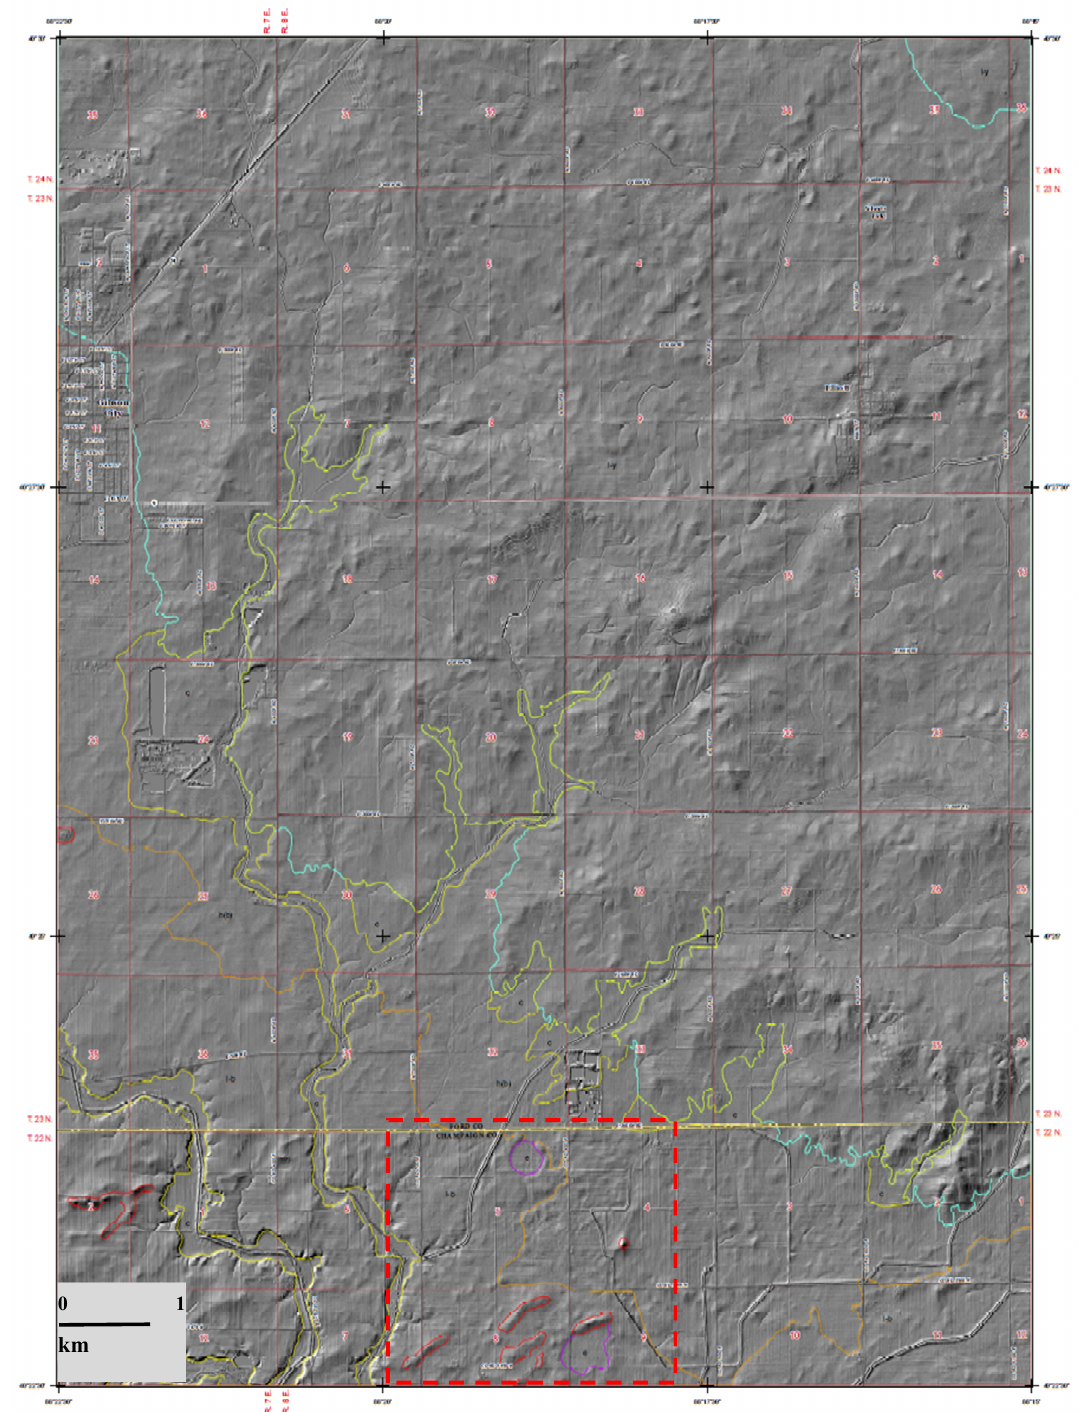
Figure 4. LiDAR hillshaded DEM depicting the following geomorphologic features within the Gibson City East Quadrangle: morainic system outlined in blue (and yellow where the boundary is shared with alluvium), flood plains/river channels outlined in yellow, outwash plain outlined in brown, glacial lake plains outlined in purple, and esker/kame-type features in red. Red numbers indicate the section lines. Dashed red line outlines the area illustrated in Figure 5.